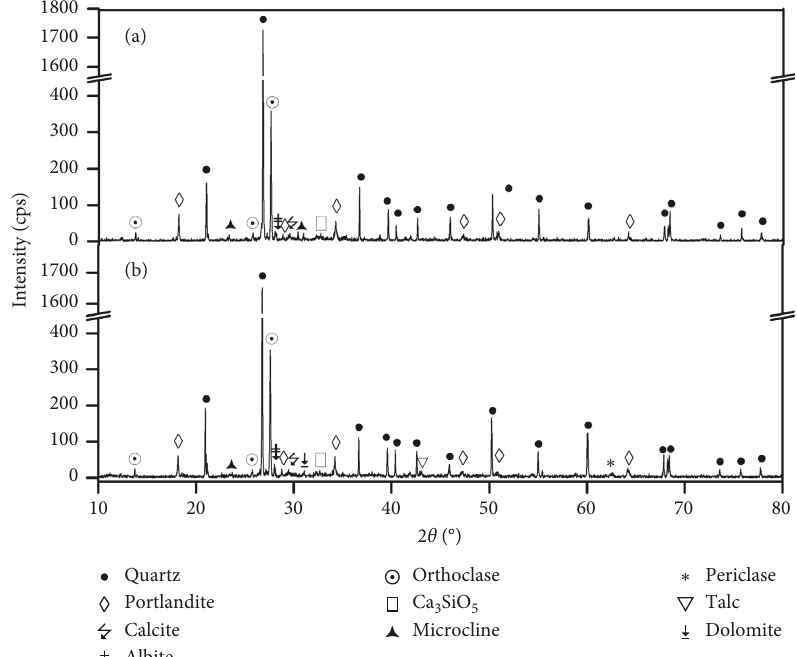
Figure 6: XRD analysis of the (a) control mortar (CM) and (b) mortar with 20% MgO A